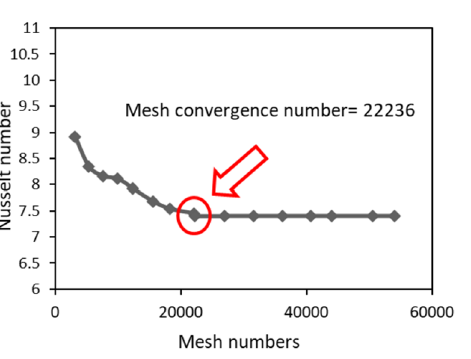
Fig. 2 Mesh convergence diagram , Re = 200, S = 0.2, BR = 0.4, θ = 90°